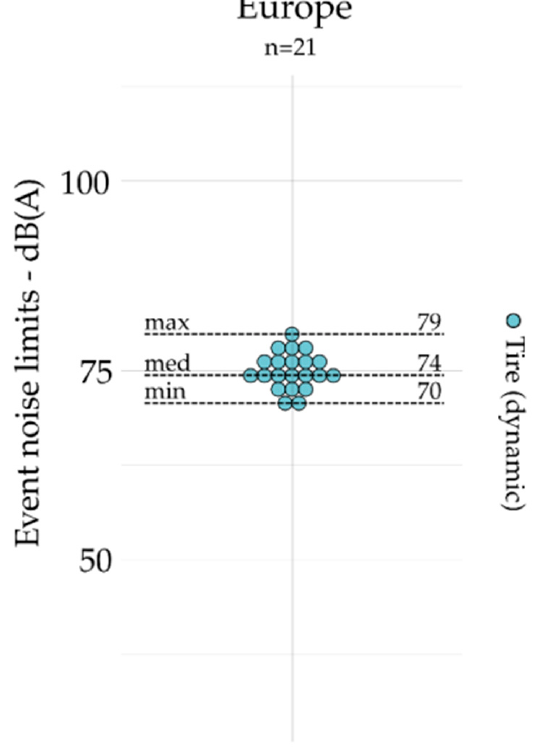
Figure 5. Event indicators for emission (i.e., tire) and grouped by geographic area ( n = 21).